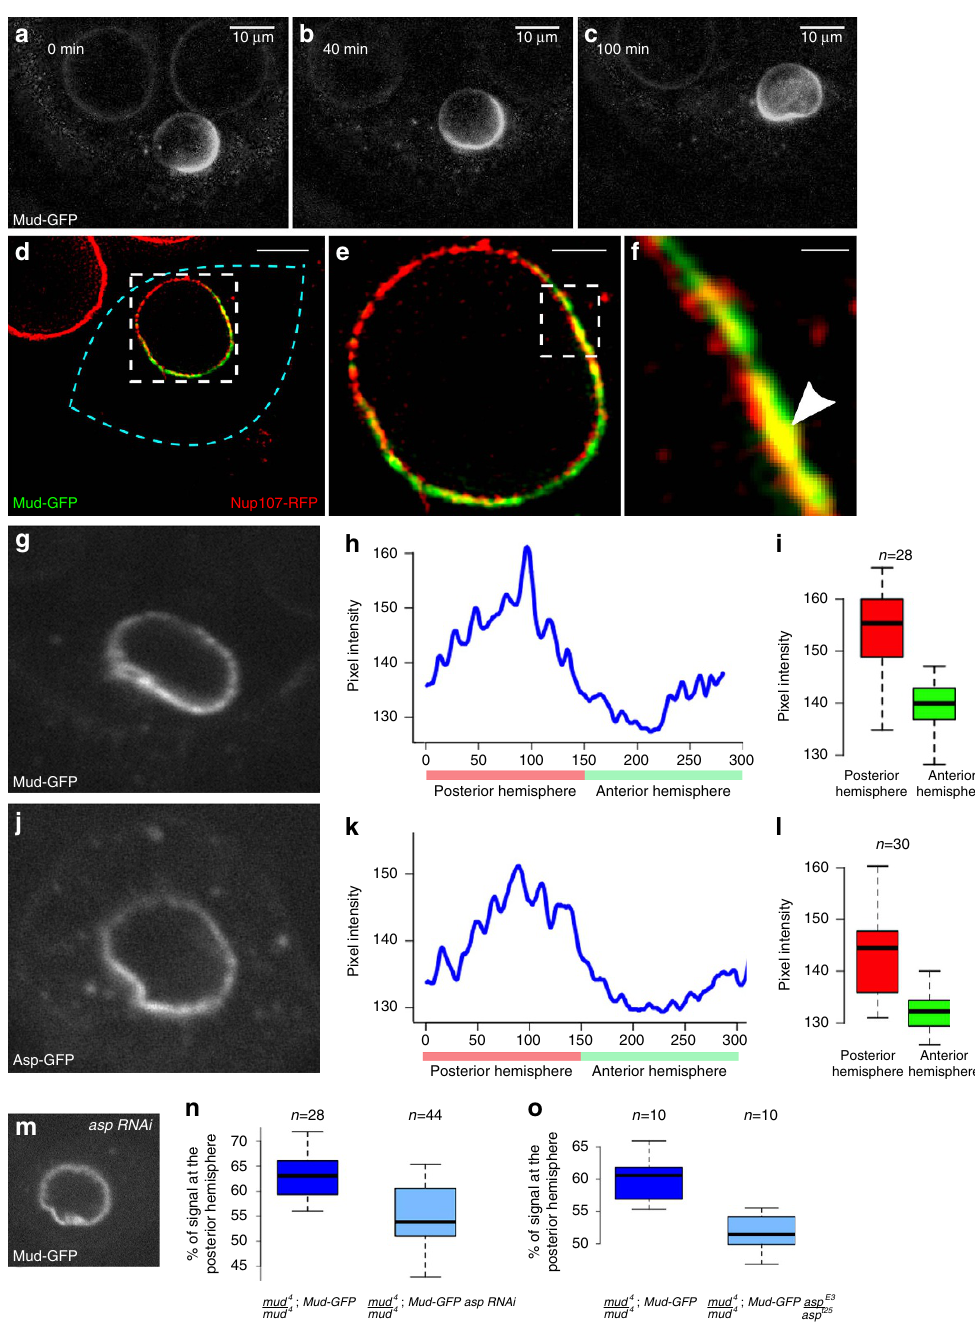
Figure 6 | Asp controls Mud asymmetric distribution at the nuclear envelope. ( a – c ) Selected frames extracted from a time-lapse movie showing Mud-GFP distribution during nuclear migration. ( d – f ) Live SIM microscopy illustrating the asymmetric distribution of Mud-GFP (green) at the nuclear envelope decorated by the nucleoporin Nup107-RFP (red). ( d ) The blue dashed line highlights the limits of a stage 6 oocyte. Scale bar, 10 m m. ( e ) Enlarged view of the region boxed in d ; scale bar 2 m m. ( f ) Enlarged view of the region boxed in e ; scale bar, 500nm. The white arrowhead points to the co-localization of Mud-GFP with Nup107- RFP at the nuclear envelope. ( g – l ) Analysis of Mud-GFP ( g – i ) and Asp-GFP ( j – l ) distributions at the nuclear envelope of a stage 6 oocyte. ( h , k ) Intensity profiles of Mud-GFP ( h ) and Asp-GFP ( k ) along the nuclear envelope of the nuclei shown in g , j , respectively. The values 0–150 (red box) correspond to the posterior hemisphere. The values 150–300 (green box) correspond to the anterior hemisphere. ( i , l ) Box plot representations of Mud-GFP ( i ) and Asp-GFP ( l ) intensities in the posterior and anterior hemispheres (Mud-GFP: n ¼ 28–pValue ¼ 3.9 (cid:3) 10 (cid:2) 6 ; Asp-GFP: n ¼ 30 – pValue ¼ 3,3 (cid:3) 10 (cid:2) 7 ). ( m ) Representative example of Mud-GFP distribution in a stage 6 asp- depleted oocyte. ( n , o ) Box plot representation of Mud-GFP intensity percentage in the posterior hemispheres of wild-type ( n ¼ 28) and asp -depleted oocytes ( n ¼ 44); (pValue ¼ 7.1 (cid:3) 10 (cid:2) 8 ) ( n ) and of wild-type ( n ¼ 10) and asp mutant oocytes ( n ¼ 10); (pValue ¼ 2,2 (cid:3) 10 (cid:2) 5 ) ( o ). In each case, the limits of boxplot correspond to the first and third quartiles, and the band inside is the median. The ends of the whiskers represent the minimal and the maximal values. Statistical differences have been assessed by a Wilcoxon–Mann–Whitney test.